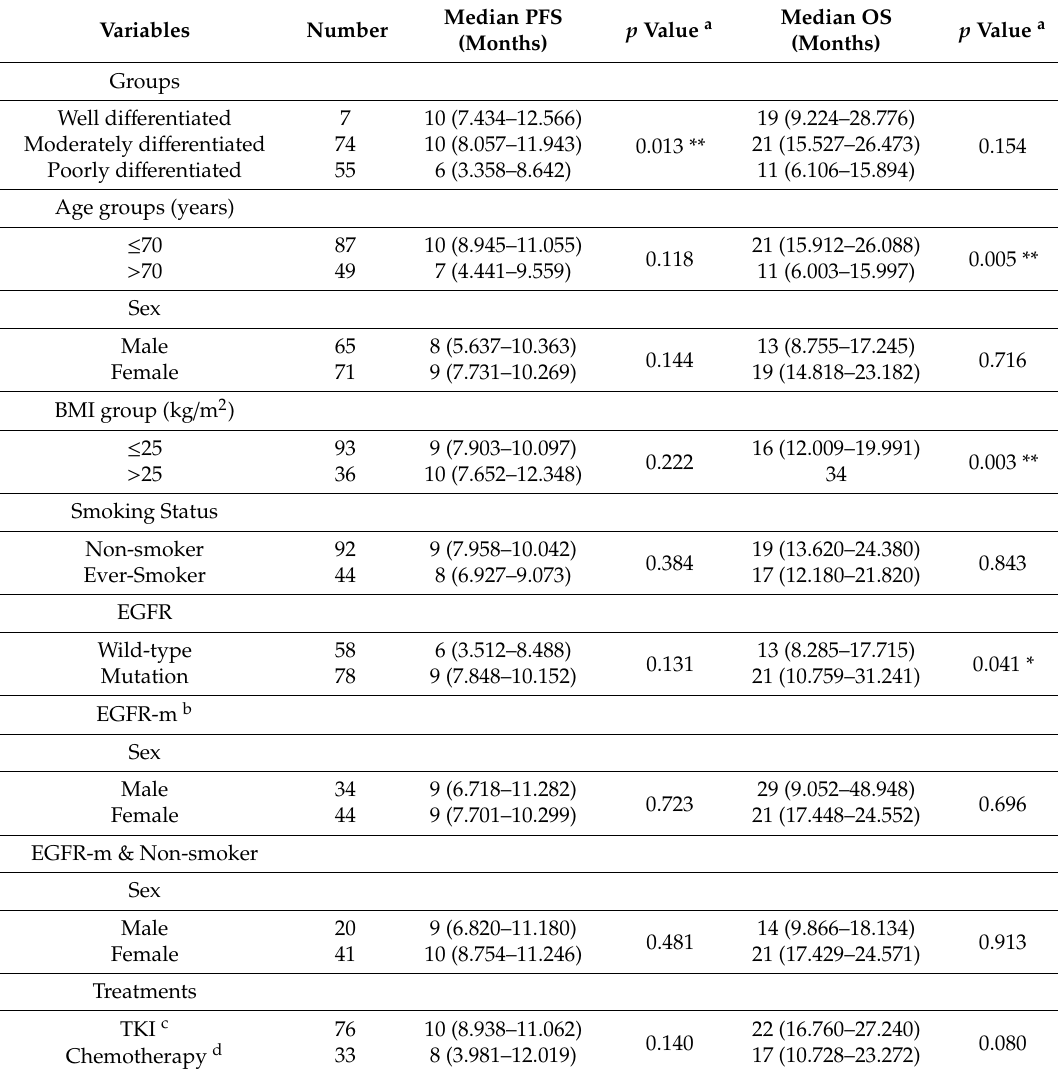
Table 5. Progression-free survival and overall survival according to baseline